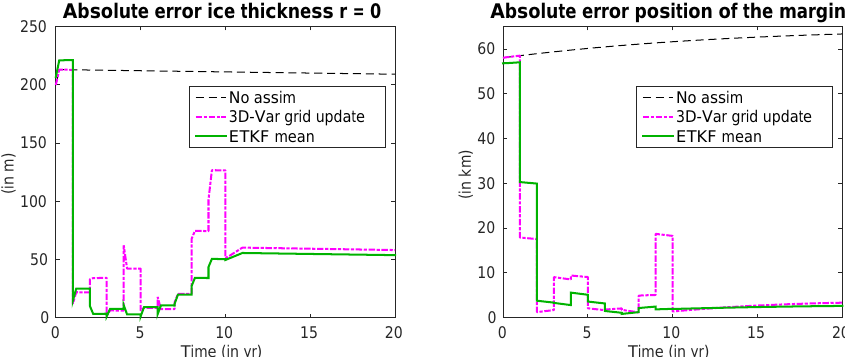
Figure 15. Evolution of the absolute error of the estimated ice thickness at r = 0 and the estimated position of the margin in the advanced configuration where we assimilate surface elevations over the first 10 years. We compare the absolute errors obtained when we use 3D-Var with the correction of the position of grid nodes and when we use an ETKF. The ETKF performs better than the 3D-Var for both variables.